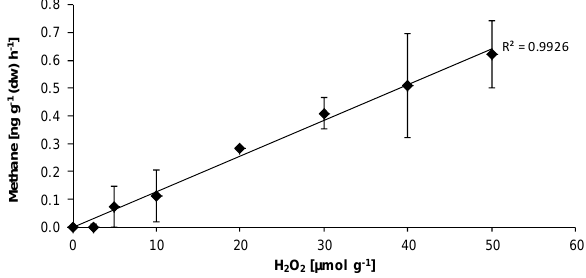
Fig. 4. Relationship between CH 4 emission from peat PH and added amount of H 2 O 2 . Data show mean value ± SD ( n =3, except 20µmol ( n =1)). Incubation: 24h at 30 ◦